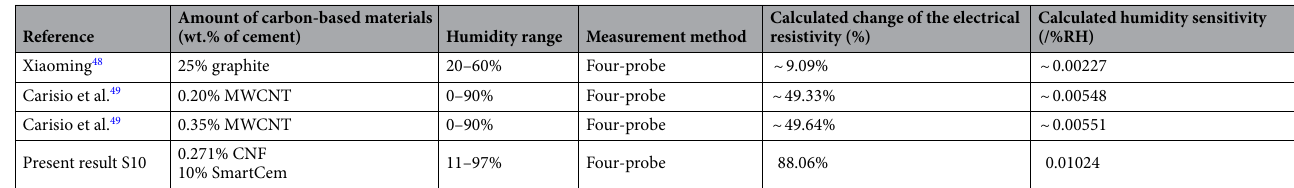
Table 5. Sensitivity to humidity of cementitious matrixes incorporating various types of carbon-based